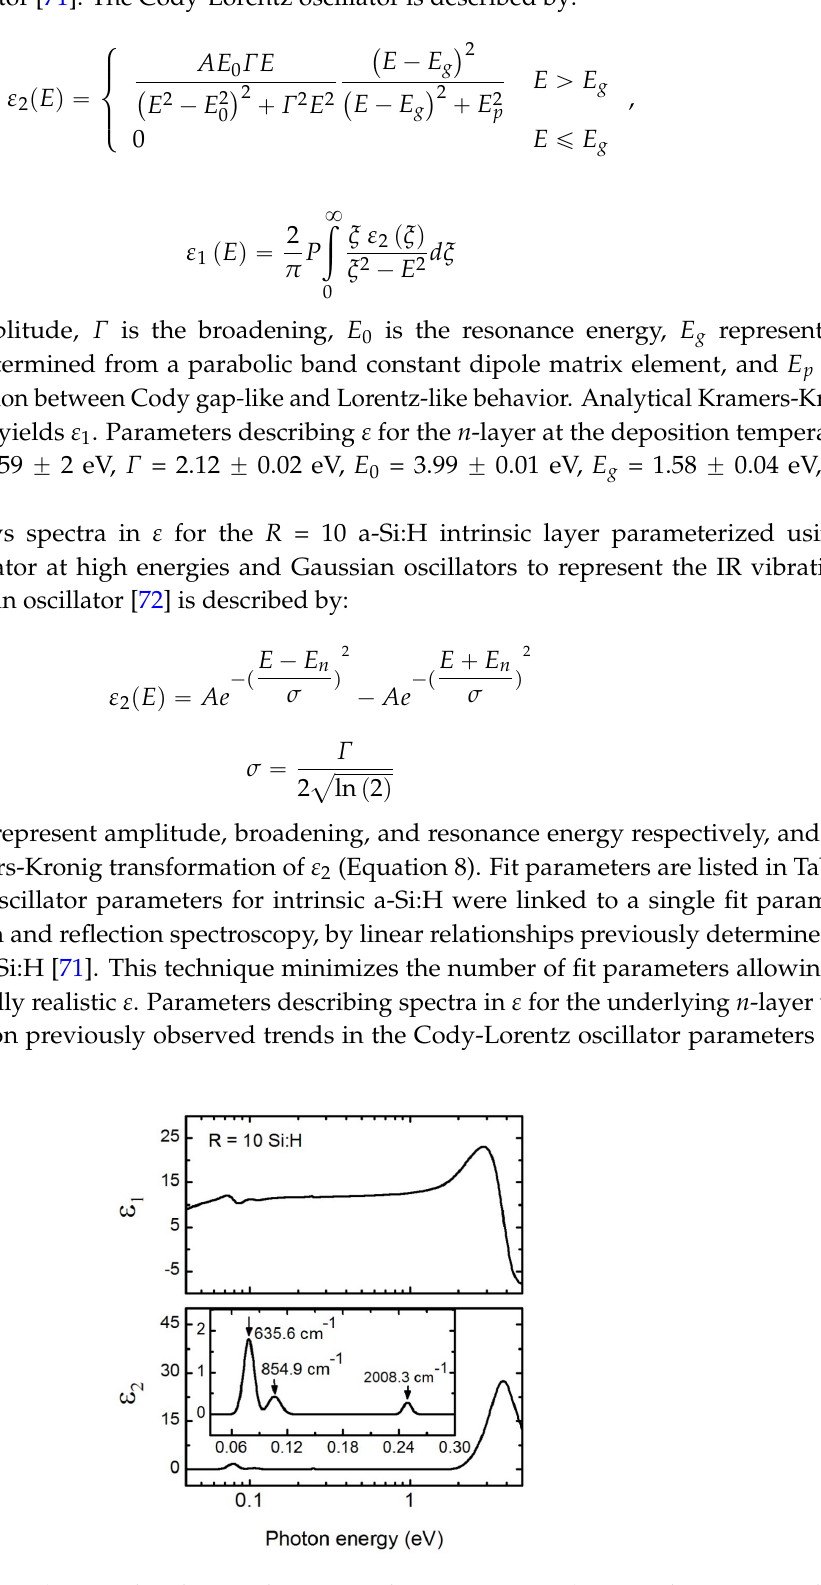
Figure 10. Spectra in ε (top panel, real part ε 1 ; bottom panel, imaginary part ε 2 ) extracted over a spectral range from 0.04 to 5 eV for 3621 2 Å R = 10 a ‐ Si:H films on BR over ‐ coated with a R = 50 n ‐ layer. The inset shows lower energy features in ε 2 as a function of photon energy representing Si ‐ H n vibrational modes as modeled by Gaussian oscillators.